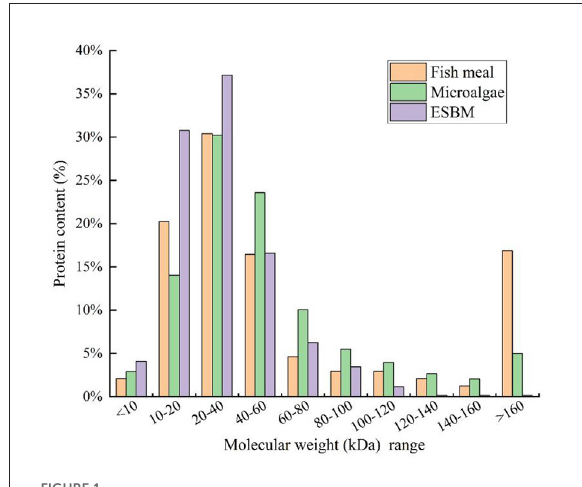
FIGURE1 Molecular weight distributions and corresponding